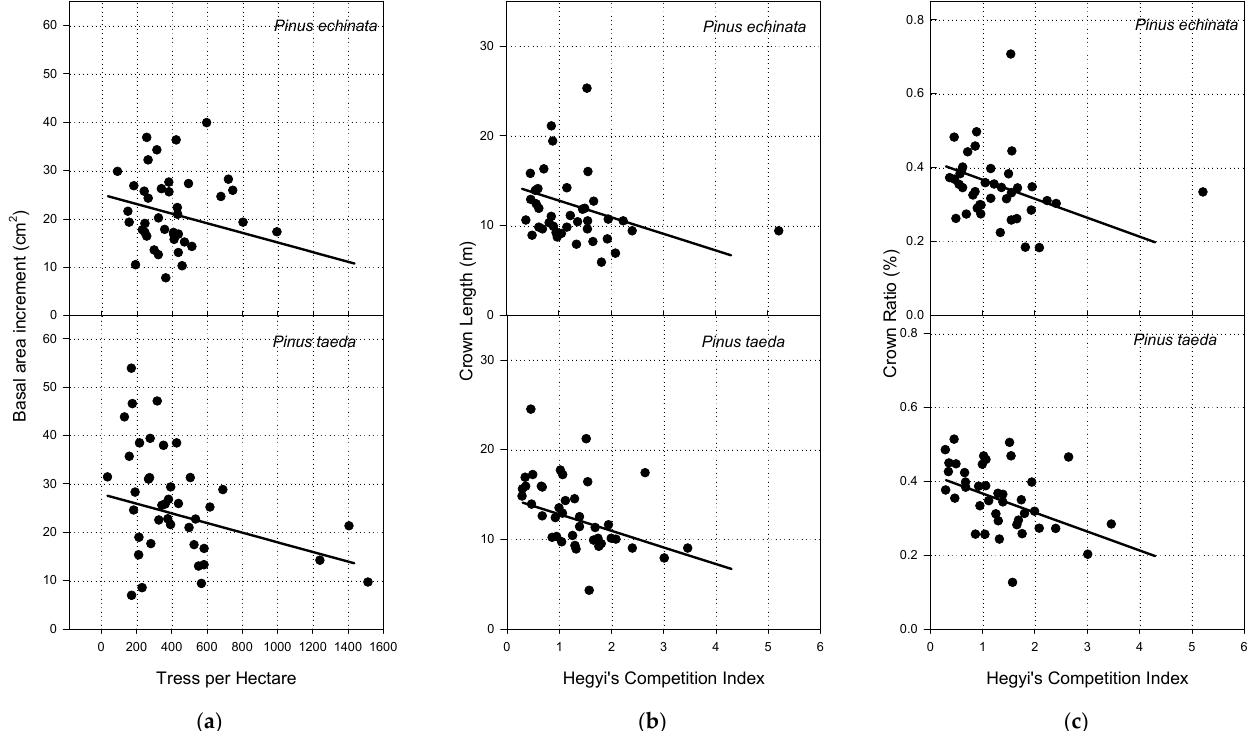
Figure 3. Focal tree: ( a ) mean basal area increment (cm 2 ); ( b ) crown length (m); ( c ) and crown ratio (%) as functions of competition indices for shortleaf ( Pinus echinata ) and loblolly pine ( Pinus taeda ) in mature, natural-origin, pine–hardwood mixtures of southeastern Arkansas.